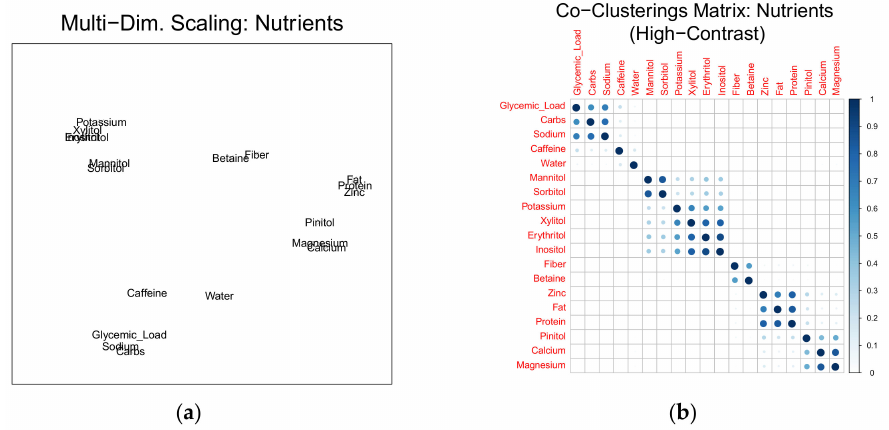
Figure 2. Graphical depictions of associations among 19 nutrients following serial k-means clustering. Multi-dimensional scaling view ( a ) and heat map of co-clusterings matrix ( b ); heat-map clarity enhanced by raising C ij values to the 7th